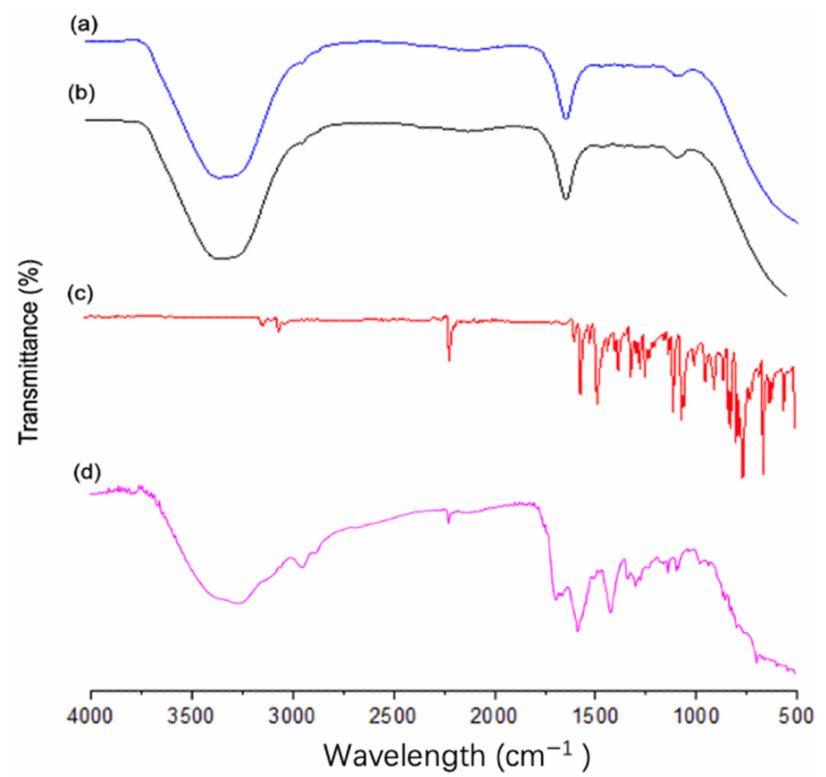
Figure 8. FT-IR spectra of LCZ-NE ( a ), blank NE ( b ), LCZ ( c ) and a physical mixture between LCZ and blank NE ( d